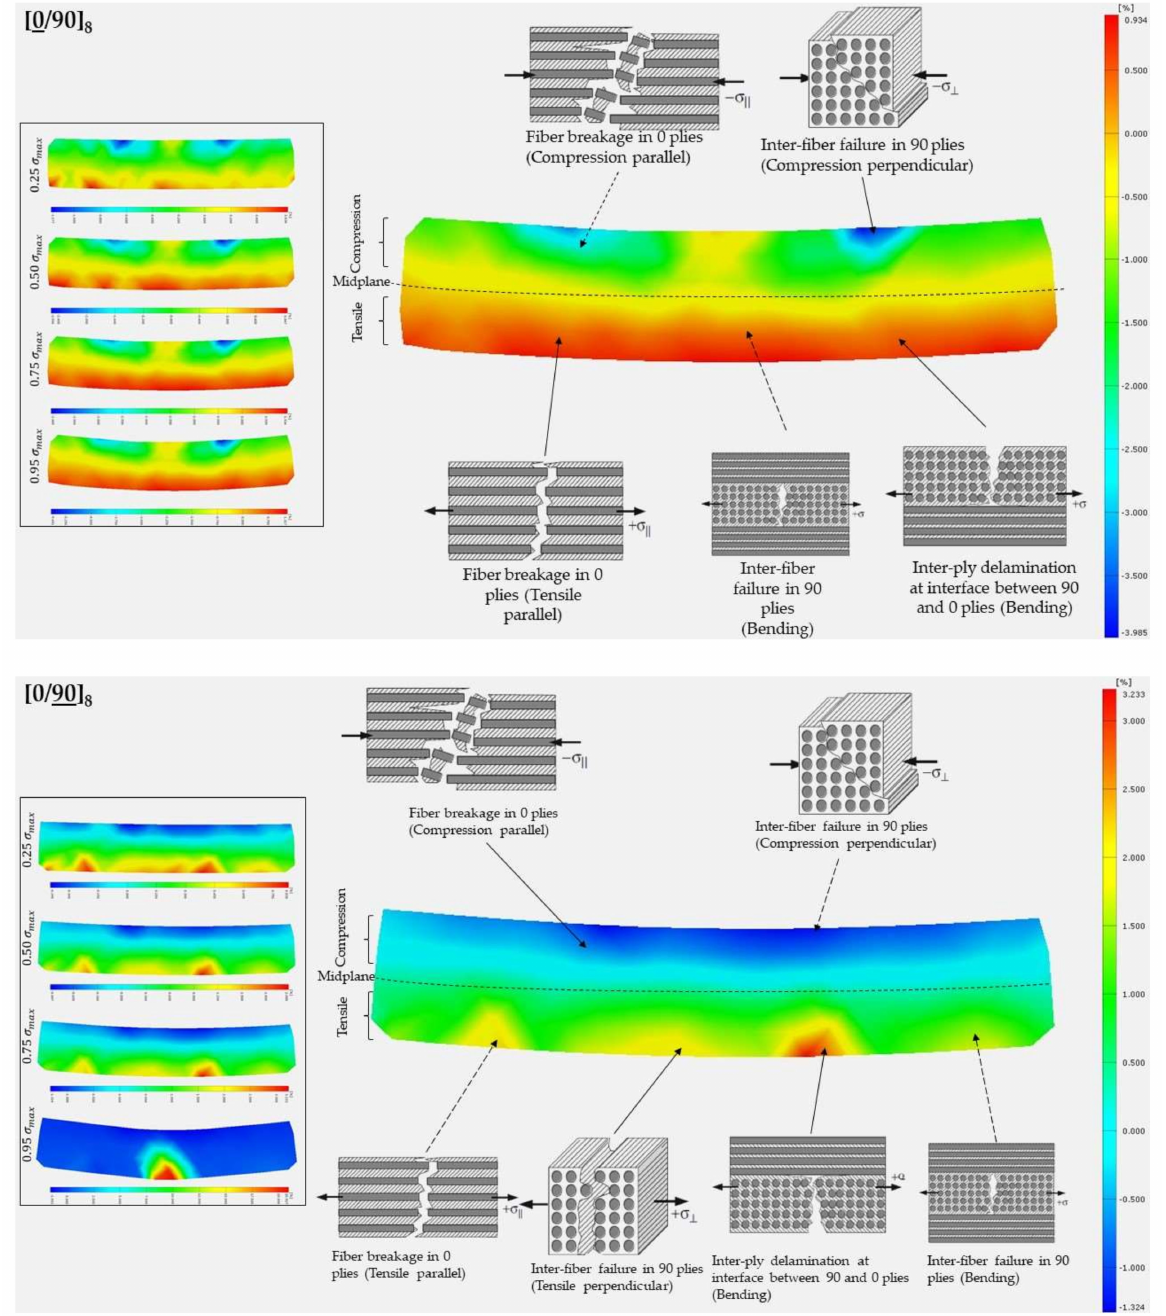
Figure 3. DIC measured ε xx strain at various load levels for [0/90] 8 and [0/90] 8